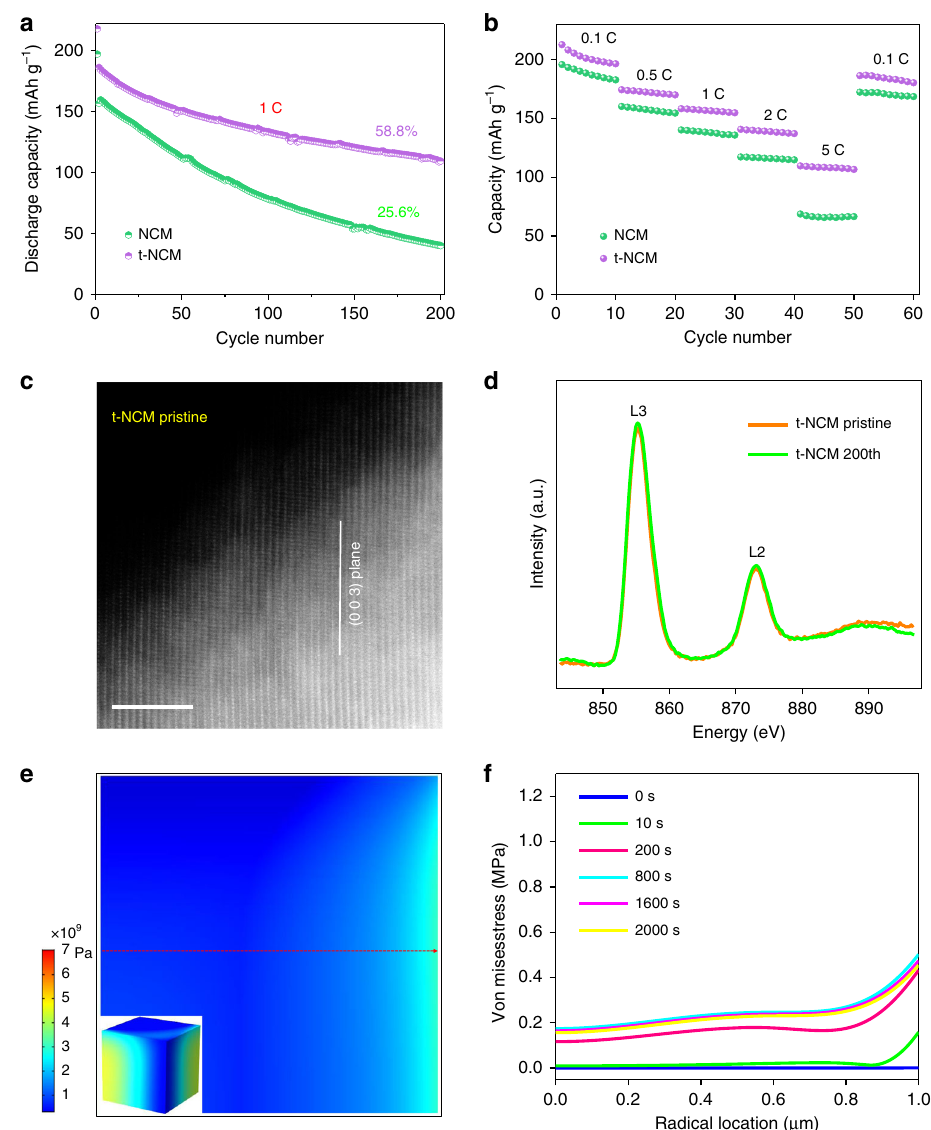
Fig. 8 Structural analysis of improved stability in the t-NCM. a Cycling performance comparison plot of untreated NCM and t-NCM. b NCM and t-NCM rate capabilities. c Atomic resolution HAADF-STEM images of pristine and cycled t-NCM samples. Scale bars 5 nm. d Soft XAS spectra of Ni L-edge for t-NCM. Equivalent stress within the NCM particles: e 2D view of the cross pro fi le. The illustration in the picture is 3D semitransparent view. f Von Mises stress within the NCM particles along the imaginary